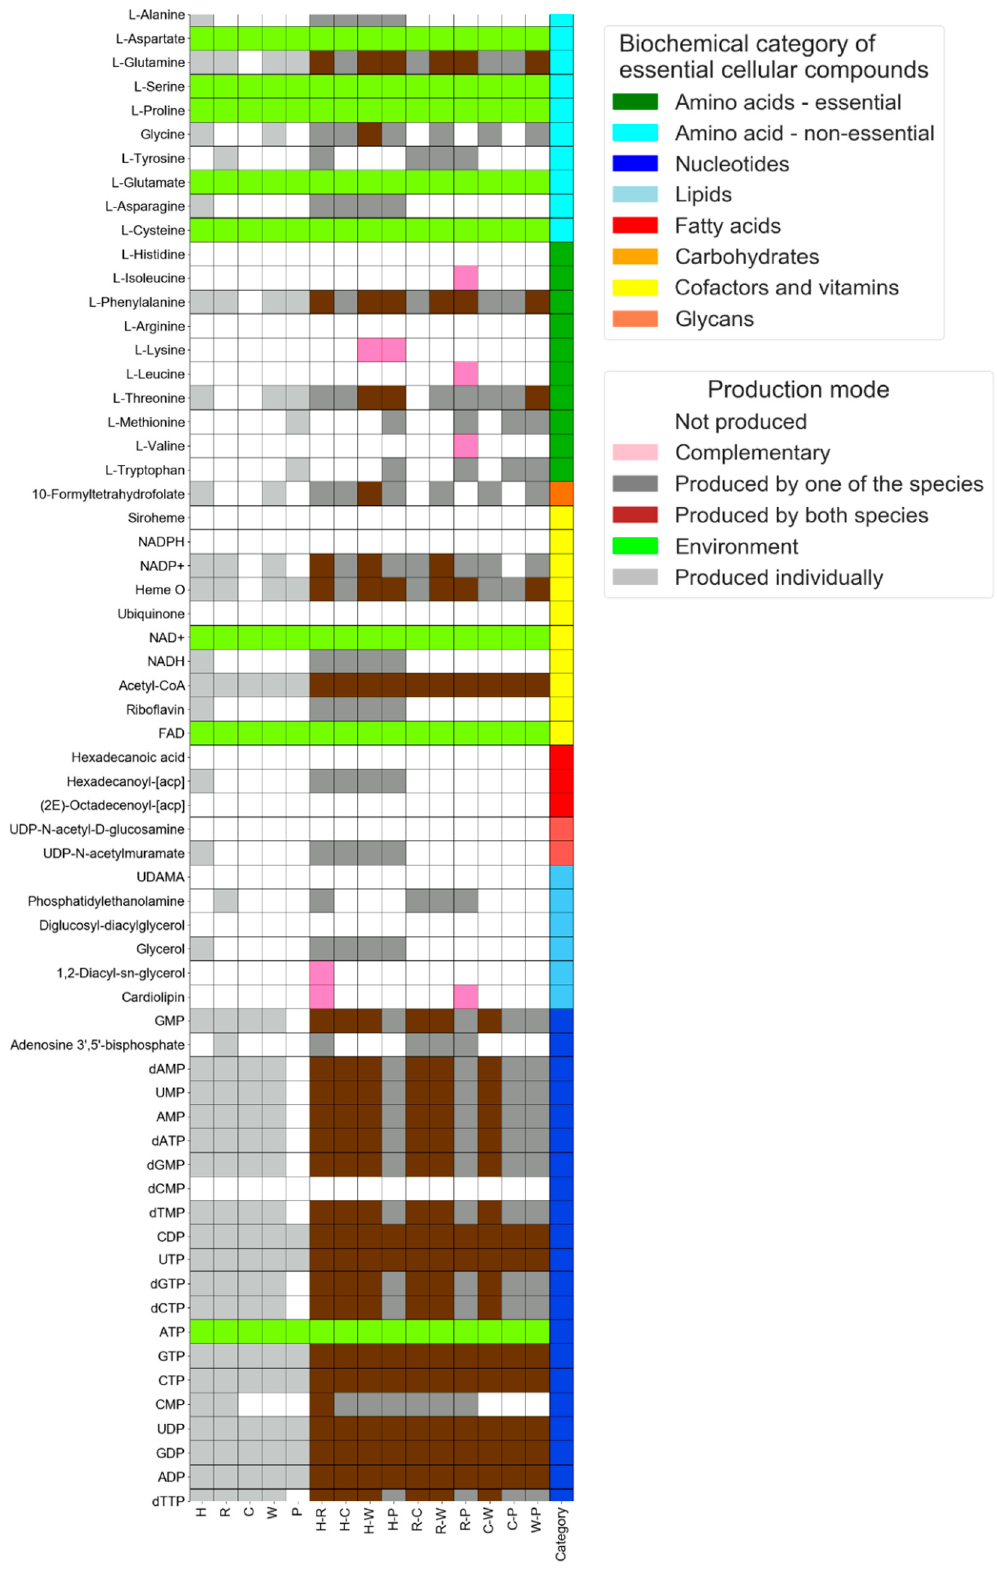
Figure 3. Profiles for the predicted production of cellular building blocks by co-residing symbionts of Bemisia tabaci and their respective pairwise combinations. X-axis: H, R, C, W & P— Hamiltonella , Rickettsia , Wolbachia , Cardinium , and Portiera respectively. Y-axis: key cellular building blocks.